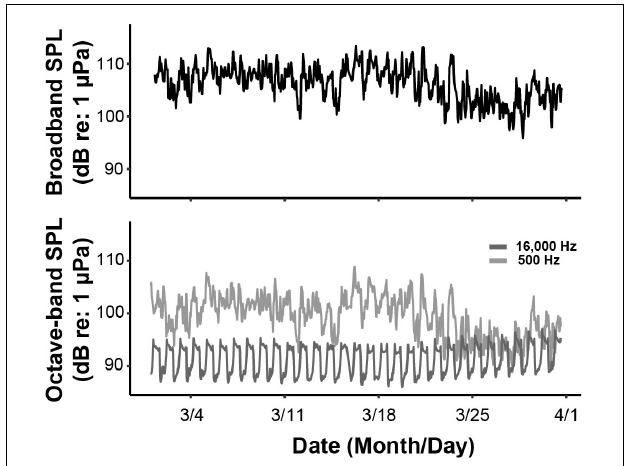
FIGURE 4 | Spectral features in sound levels expose multiple sources. Broadband sound pressure levels (top plot, black line) show a decreasing trend in levels at a site in Hawaiian Islands Humpback Whale National Marine Sanctuary (HI01). Octave band sound pressure levels (lower plot) at 500-Hz (light gray) and 16,000-Hz (dark gray) provide insight into differing temporal patterns of humpback whale song, dominating at 500-Hz, and snapping shrimp snaps, dominating at